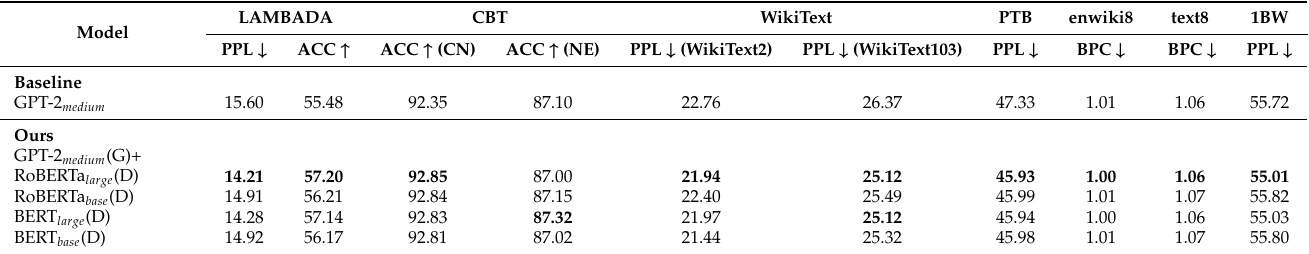
Table 5. After 156 minibatch-sized EvoText sessions, we evaluated the performance of various natural language understanding models (D) and the same language generation model (GPT medium ) on 7 natural language processing tasks ZERO-SHOT. Each model was tested five times on each task, and the results were averaged.